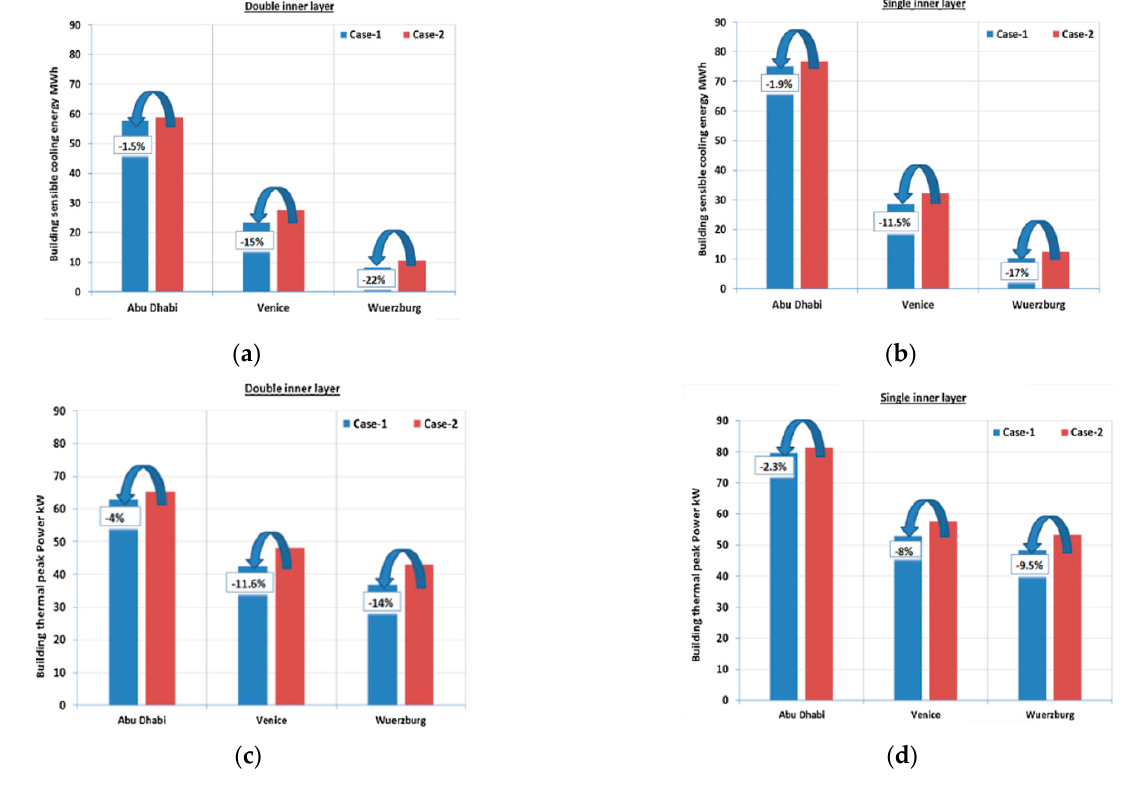
Figure 8. Seasonal energy consumption during the cooling period ( a ) building cooling energy for the case with DL, ( b ) building cooling energy for the case with SL, ( c ) building peak power for the case with DL, ( d ) building peak power for the case with SL (reprinted from [105]) .